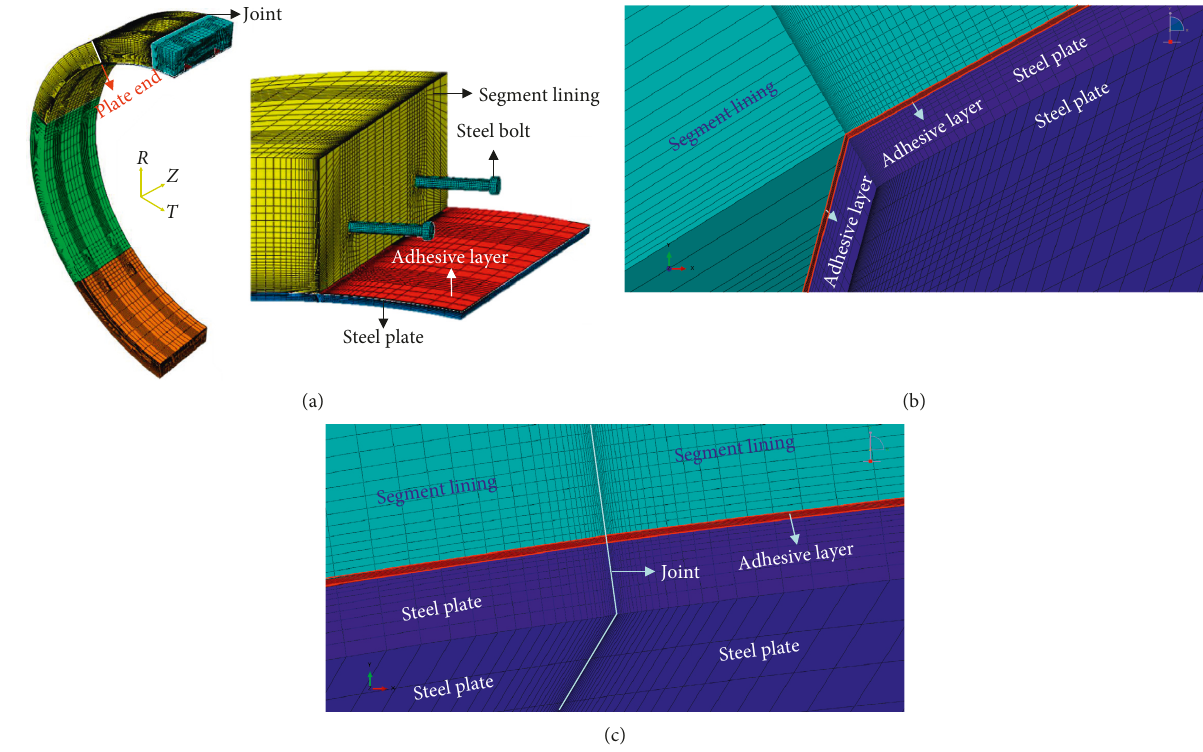
Figure 4: Mode mesh details. (a) Overall view. (b) Detailed view near plate end. (c) Detailed view near